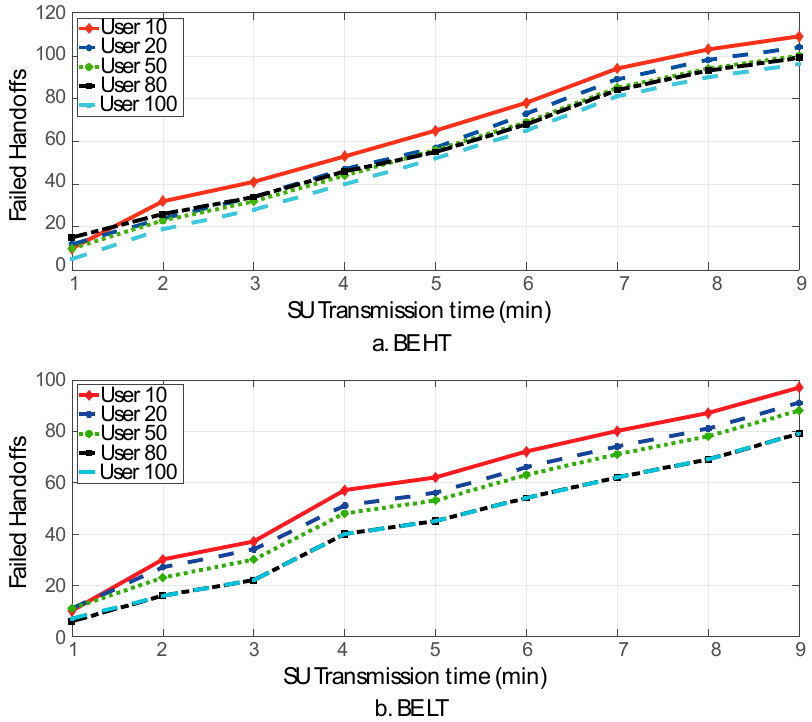
Figure 16. Failed handoffs for FFAHP: ( a ) Best effort (BE) and high traffic (HT); ( b ) Best effort (BT) and low traffic (LT).